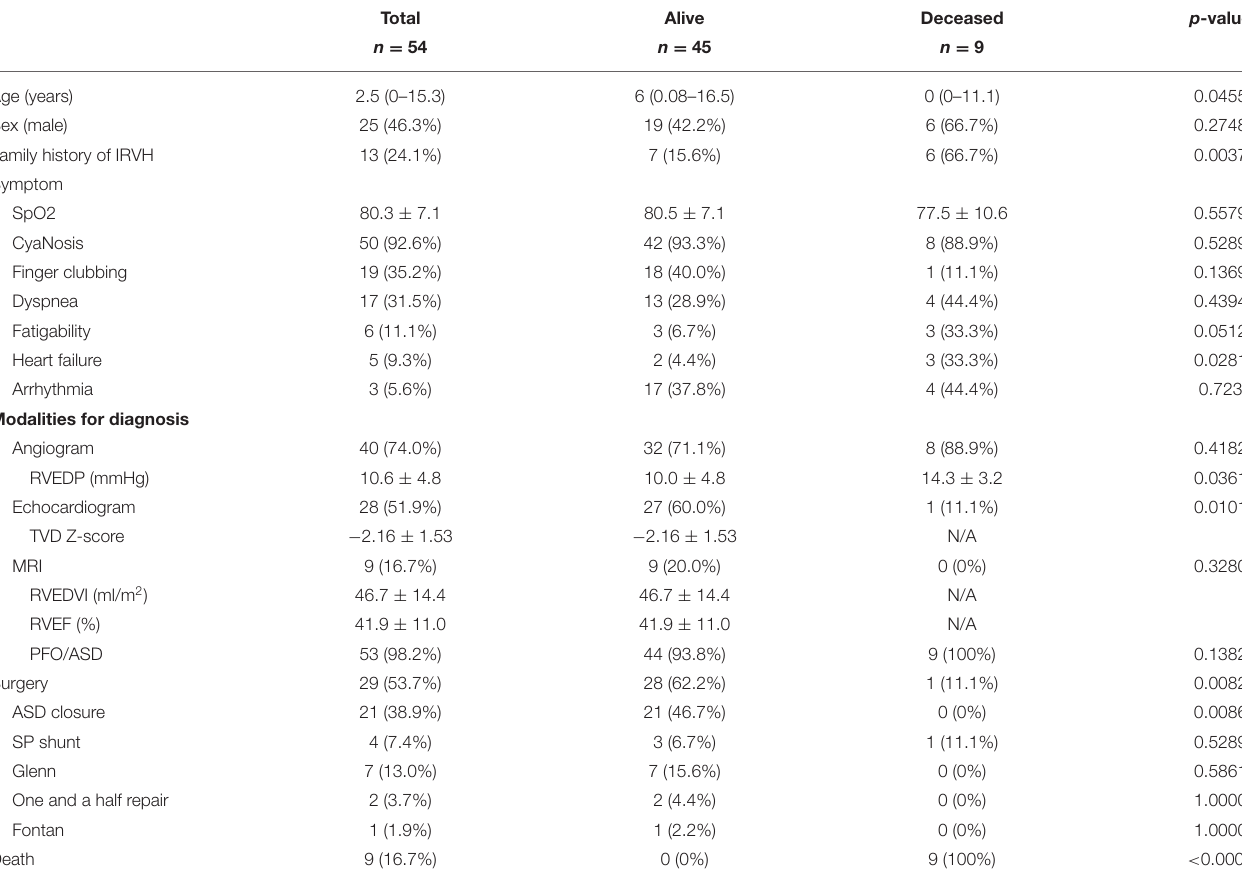
TABLE 2 | Clinical characteristics of isolated right ventricular hypoplasia from previous studies. Total Alive Deceased p